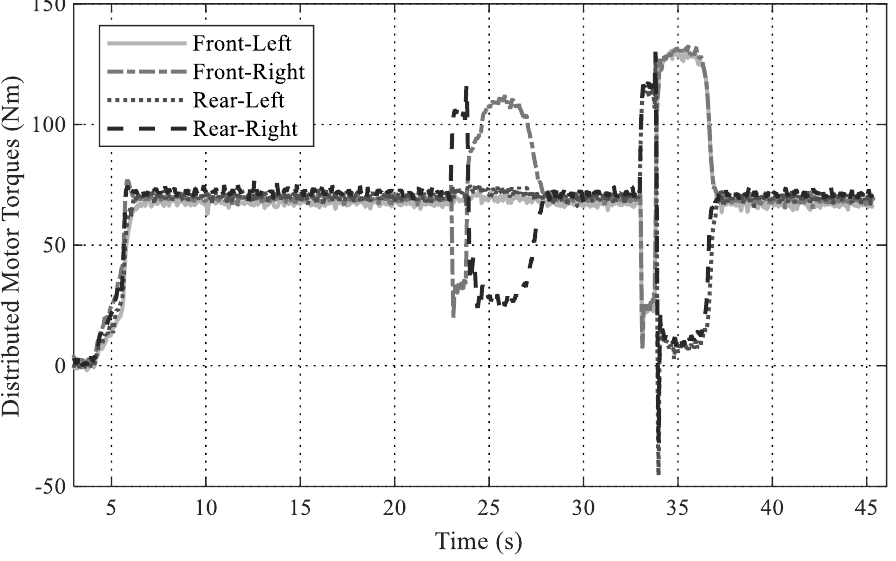
Figure 21. Distributed Motor Torque Generated by the Control System.